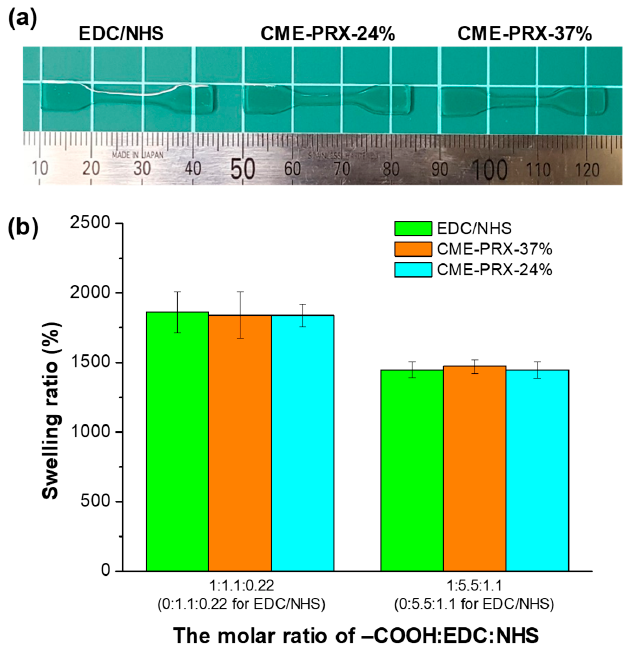
Figure 3. ( a ) Gross images of gelatin hydrogels cross-linked by EDC/NHS, CME-PRX-24%, and CME-